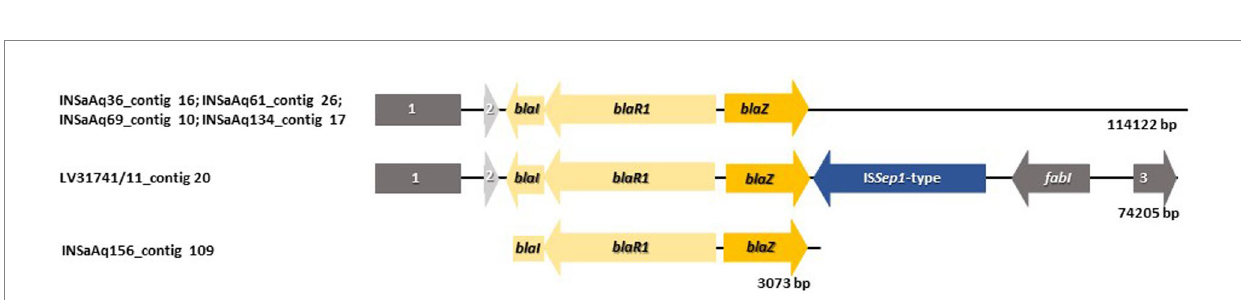
FIGURE 4 Genetic environment of blaZ gene identified in 6 out of 7 strains with animal origin (except for INSAq83 isolated from muscle of gilthead seabream). Arrows are drawn to scale. Genes in dark grey correspond to normal functions of the bacterial cell. Genes in yellow are related with antibiotic resistance. Genes in blue are associated with mobile genetic elements. 1-Lactonase family protein. 2-Hypothetical protein. 3-YolD-like family